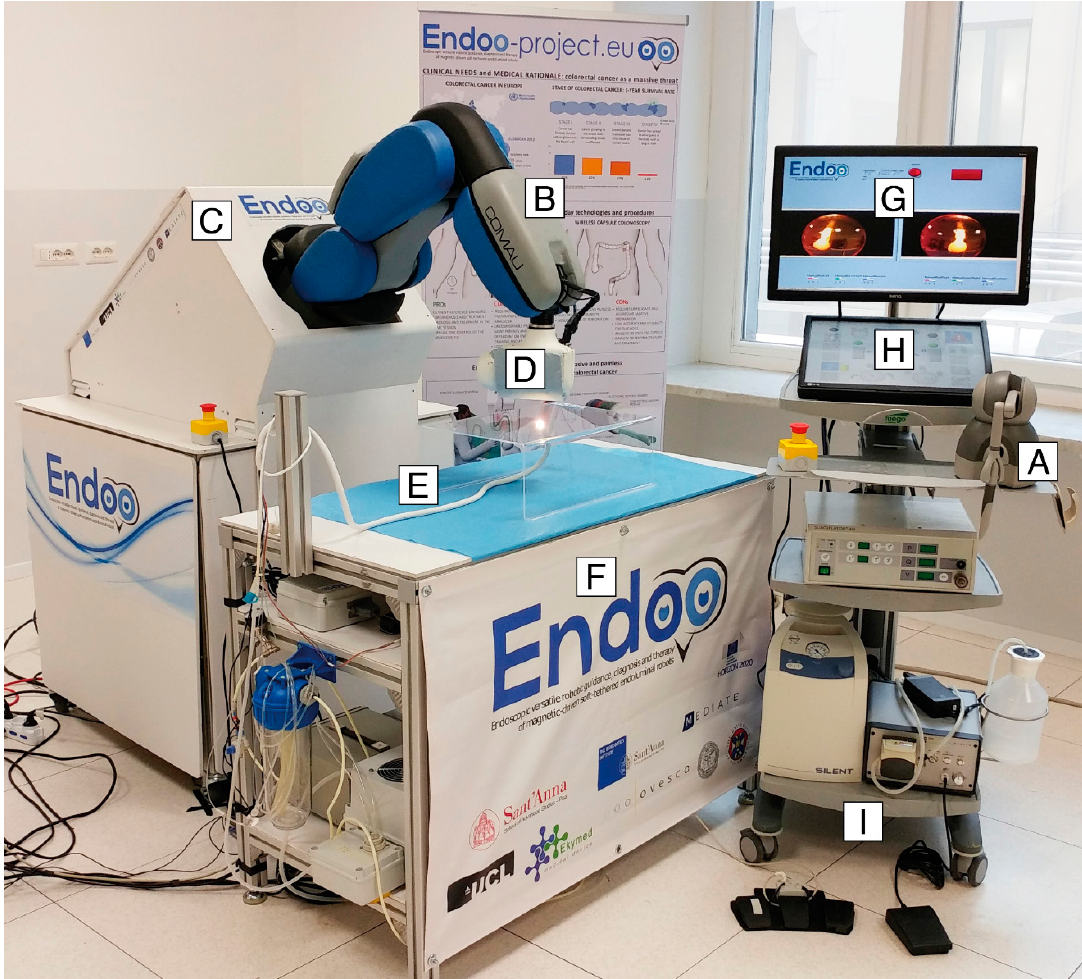
Figure 1. The Endoo robotic colonoscopy system: ( A ) haptic interface (joystick), ( B )